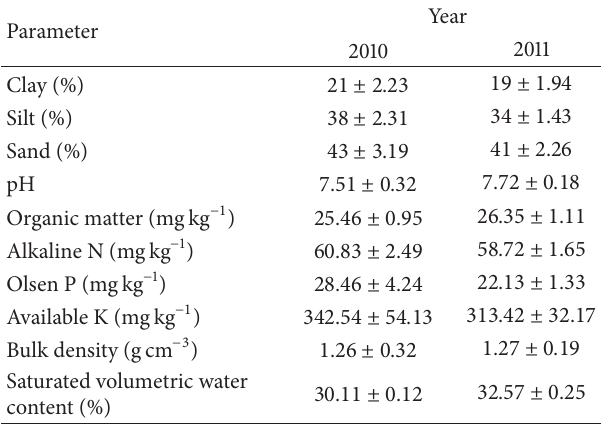
Table 1: Selected soil physical and chemical properties (0–60cm depth) in experiment